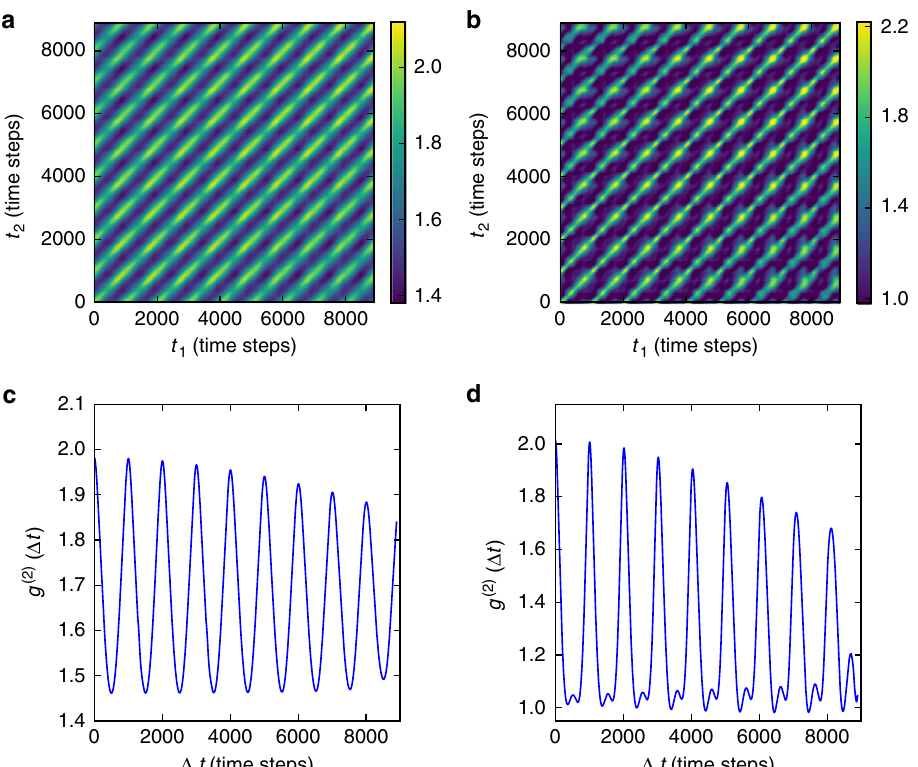
Fig. 6 Numerical results for the Zeno model. a Two-time correlations calculated at 0.39 inverse lattice units, which corresponds to a length of 16 units. b Two-time correlations calculated at 0.91 inverse lattice units, corresponding to 7 units. c g (2) ( Δ t ) autocorrelations at 0.39 inverse lattice units ( d ) g (2) ( Δ t ) autocorrelations at 0.91 inverse lattice